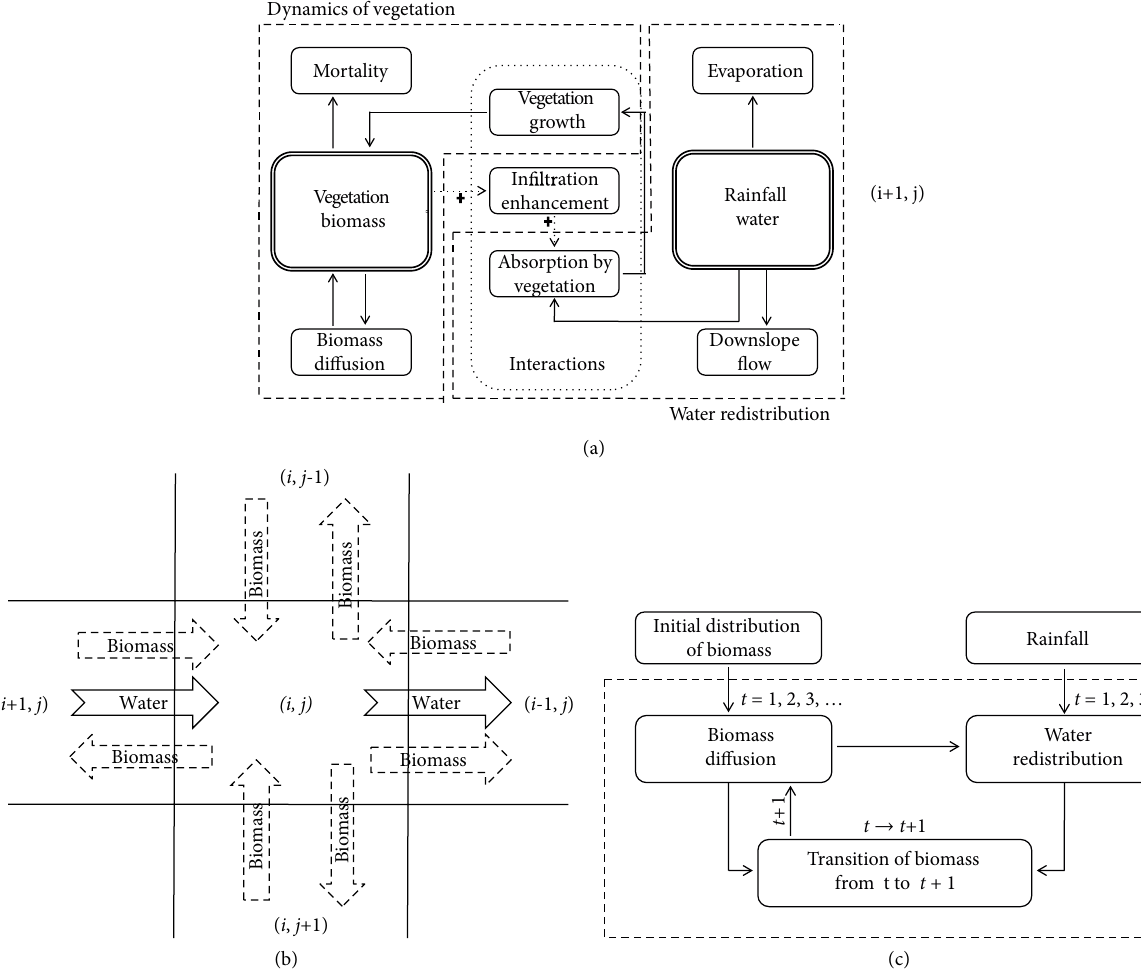
Figure 1: Outlines for (a) the Klausmeier’s model, (b) biomass diffusion and water flow in discrete space, and (c) the coupled map lattice